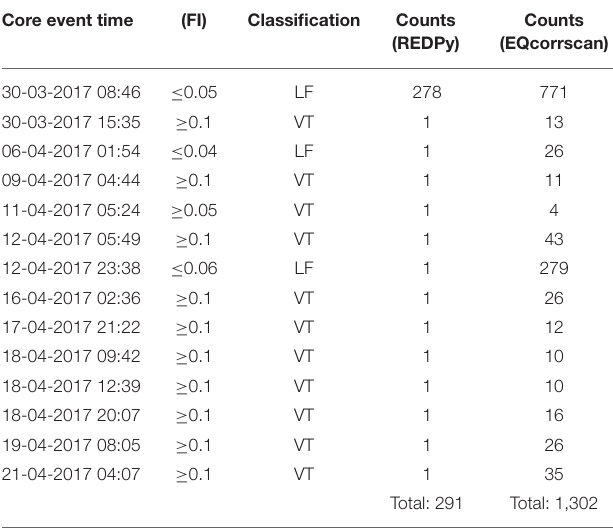
TABLE 1 | Details of fourteen families of similar seismicity identified in this